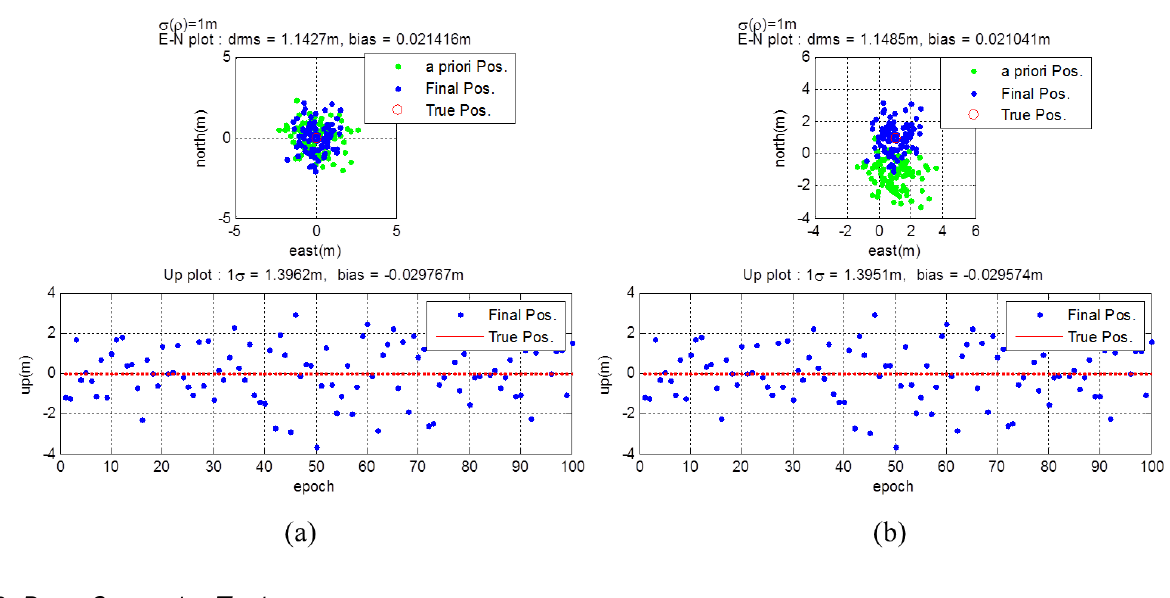
Figure 14. ( a ) Estimation results for user #1 ( b ) Estimation results for user